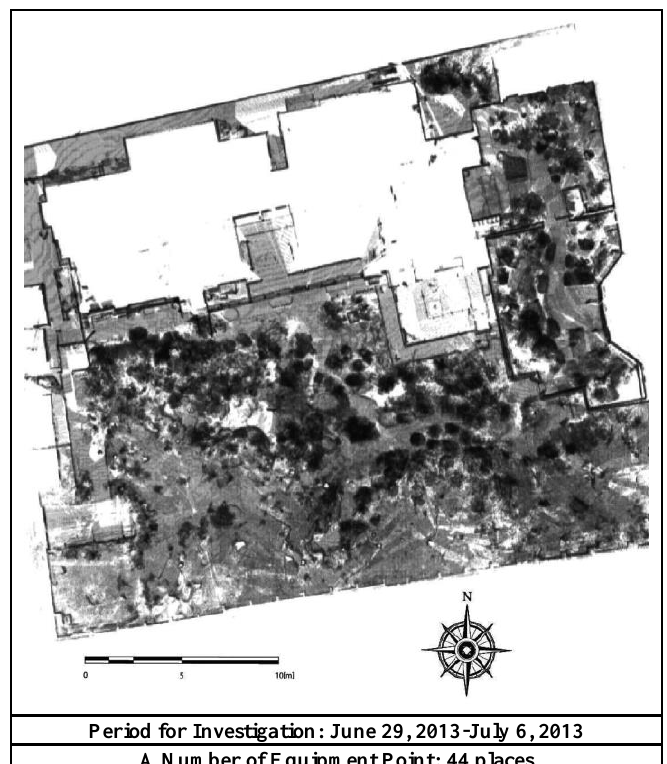
Figure 3. The point density map of each group